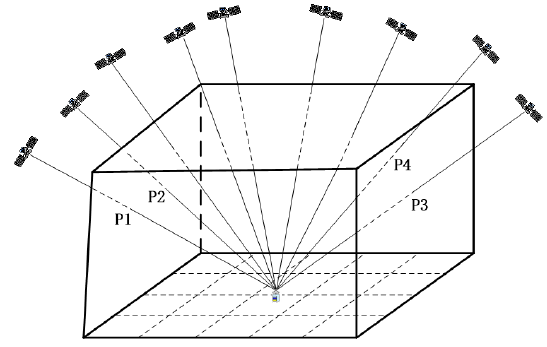
Figure 1. Three-dimensional distribution of satellite signals.